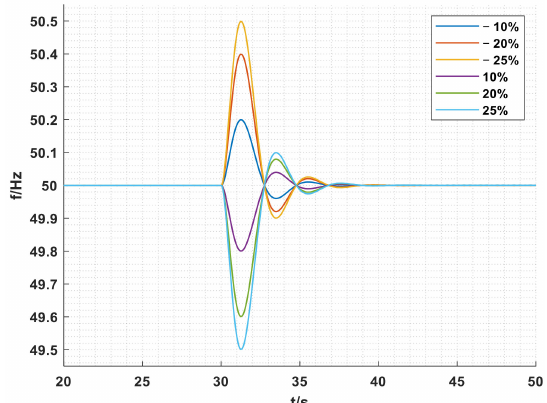
Figure 9. Frequency Change amplitude Calculation—Simulation Results Considering the secondary